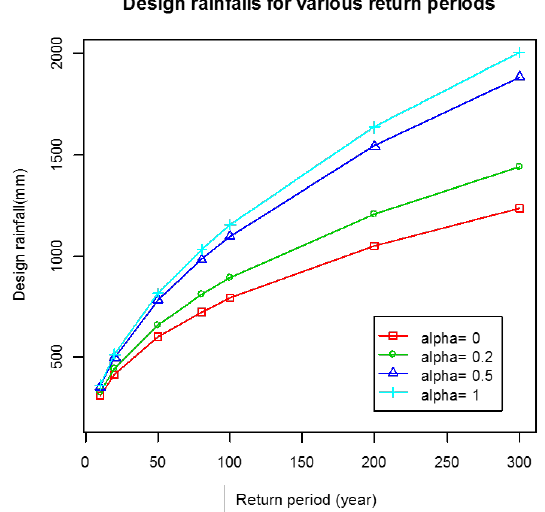
Figure 8. Estimated design rainfall from the GEV fitted to 24-h annual maxima at Gangneung (Station 105).